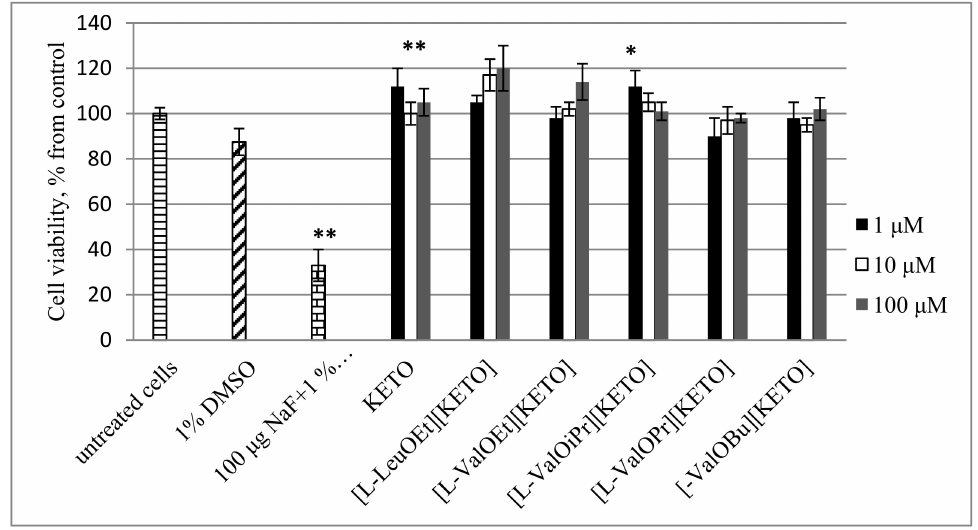
Figure 2. E ff ect of ketoprofen-based ionic liquids (ILs) on the percentage of cell viability in RAW 264.7 macrophages. Control cells were treated with media alone. Values are the mean ± standard error of the mean of three independent experiments. ** p < 0.01, * p < 0.05